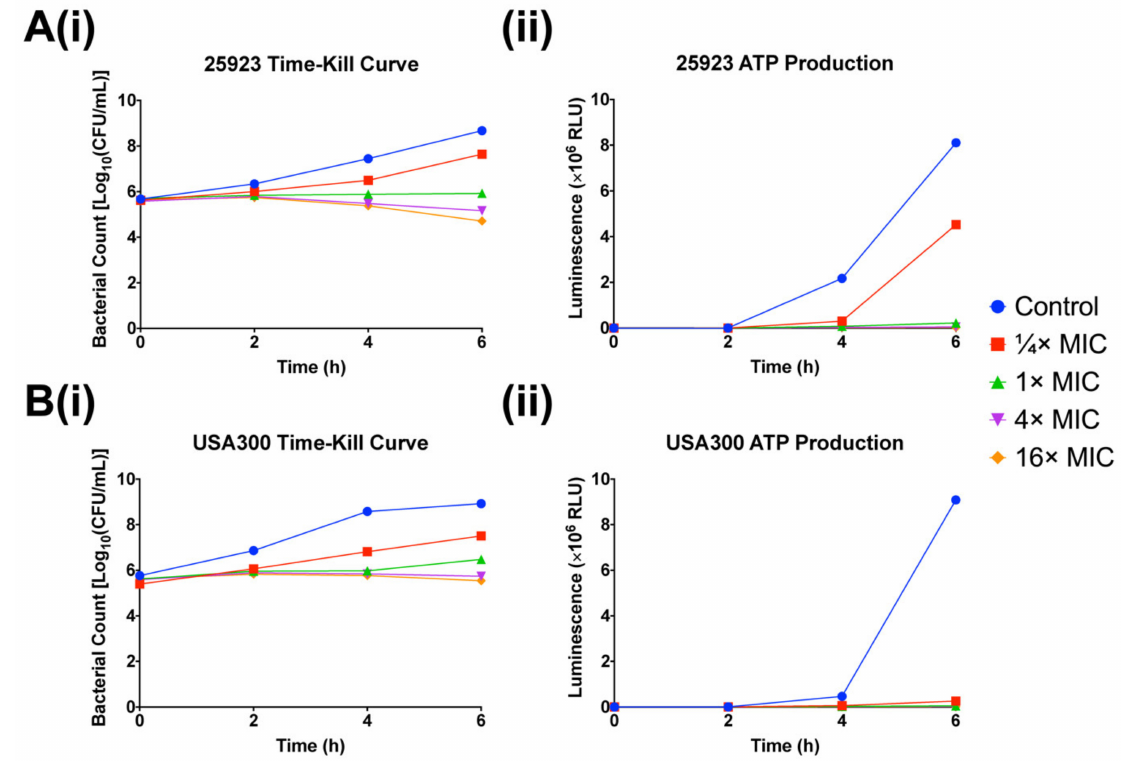
Figure 3. E ff ects of MC4 on the ( i ) time–kill kinetics and ( ii ) ATP production of ( A ) S. aureus type strain ATCC ® 25923 and ( B ) CA-MRSA strain USA300 when challenged at 1 media. Experiments were repeated in triplicates. 25923: S. aureus ATCC ® 25923; USA300: CA-MRSA strain